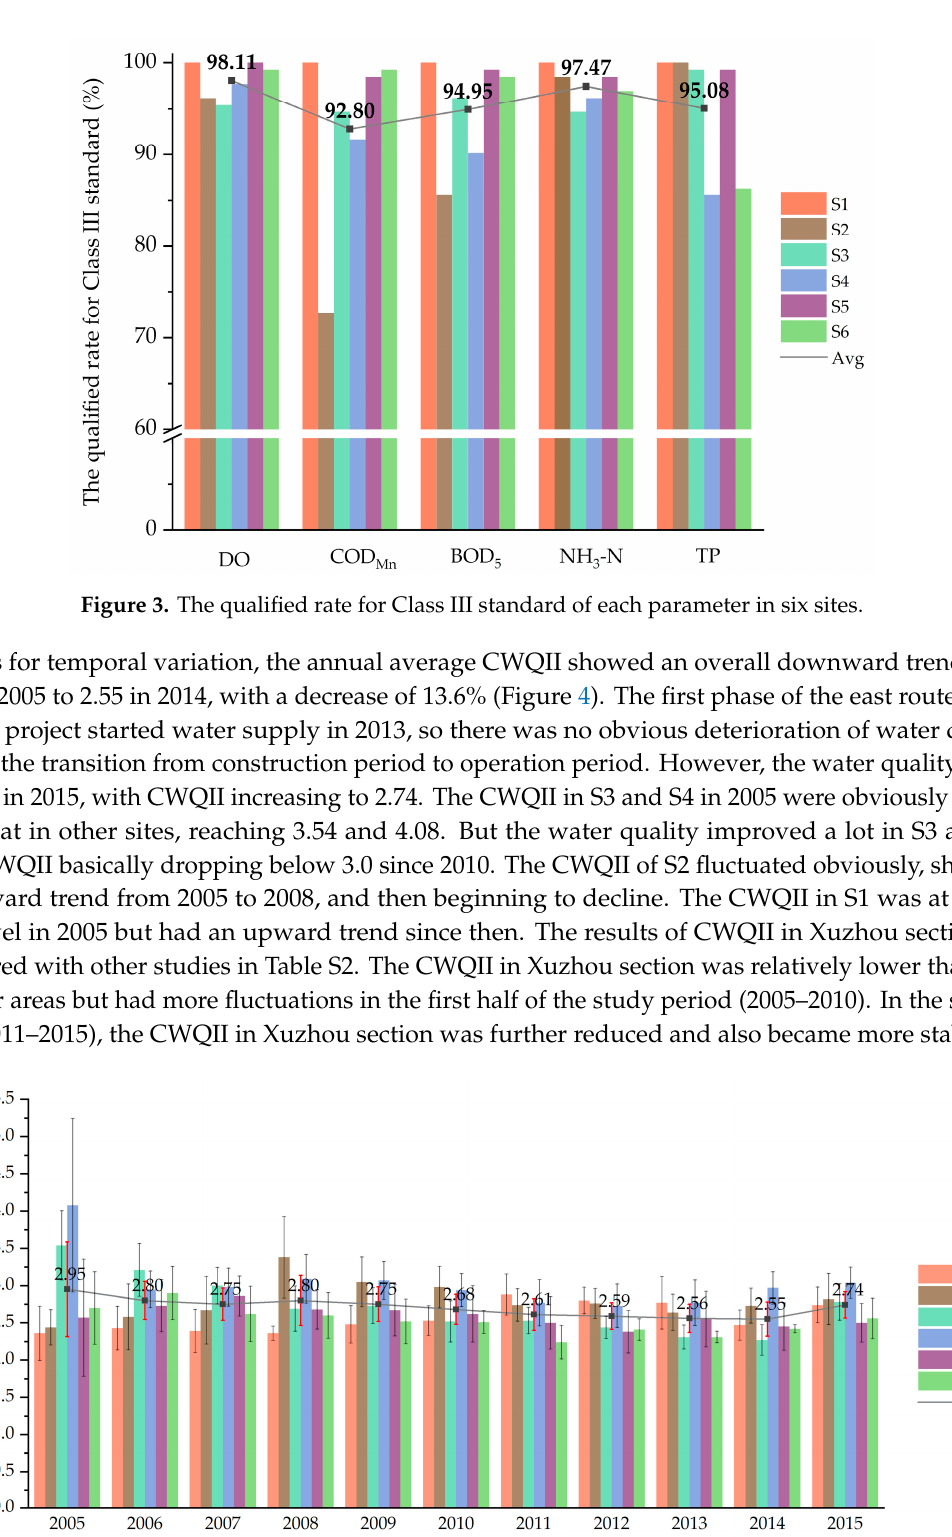
8 of 21 Figure 2. Box plots of ( a ) DO, ( b ) COD Mn , ( c ) BOD 5 , ( d ) NH 3 -N, ( e ) TP, and ( f ) CWQII (comprehensive water quality identification index) for the six sites in Xuzhou section. The year when the maximum and minimum values of each water quality parameter occurred are marked in the box plot. The maximum values of DO and the minimum values of the other four parameters were defined as the best values, and the minimum values of DO and the maximum values of the other four were defined as the worst values. As shown in Figure 2, most of the worst values occurred before 2010. S4 was the most typical site with all the five worst values occurred in 2005. As for the best values of each parameter, most of them occurred after 2010, which showed that most sites have a positive trend of water quality. S1 was the only special one with the best values occurring before 2010 and the worst values occurring after 2010, indicating that the water quality in S1 may have a negative trend. According to the Pollution Control Planning for the East Route of the South-to-North Water Transfer Project [37], the water quality parameters in Xuzhou section had to meet the demand of China’s Environmental Quality Standard for Surface Water (GB3838-2002) Class III (DO: >5 mg/L, COD Mn : <6 mg/L, BOD 5 : <4 mg/L, NH 3 -N: <1 mg/L, TP: <0.2 mg/L). The qualified rate for Class III of each water quality parameter refers to the proportion of the samples that meet the Class III standard for each parameter. It was calculated as: 𝑄𝑅 (cid:3036) = 𝑛 (cid:3036) 𝑛 (cid:3047)(cid:3042)(cid:3047)(cid:3028)(cid:3039) × 100%